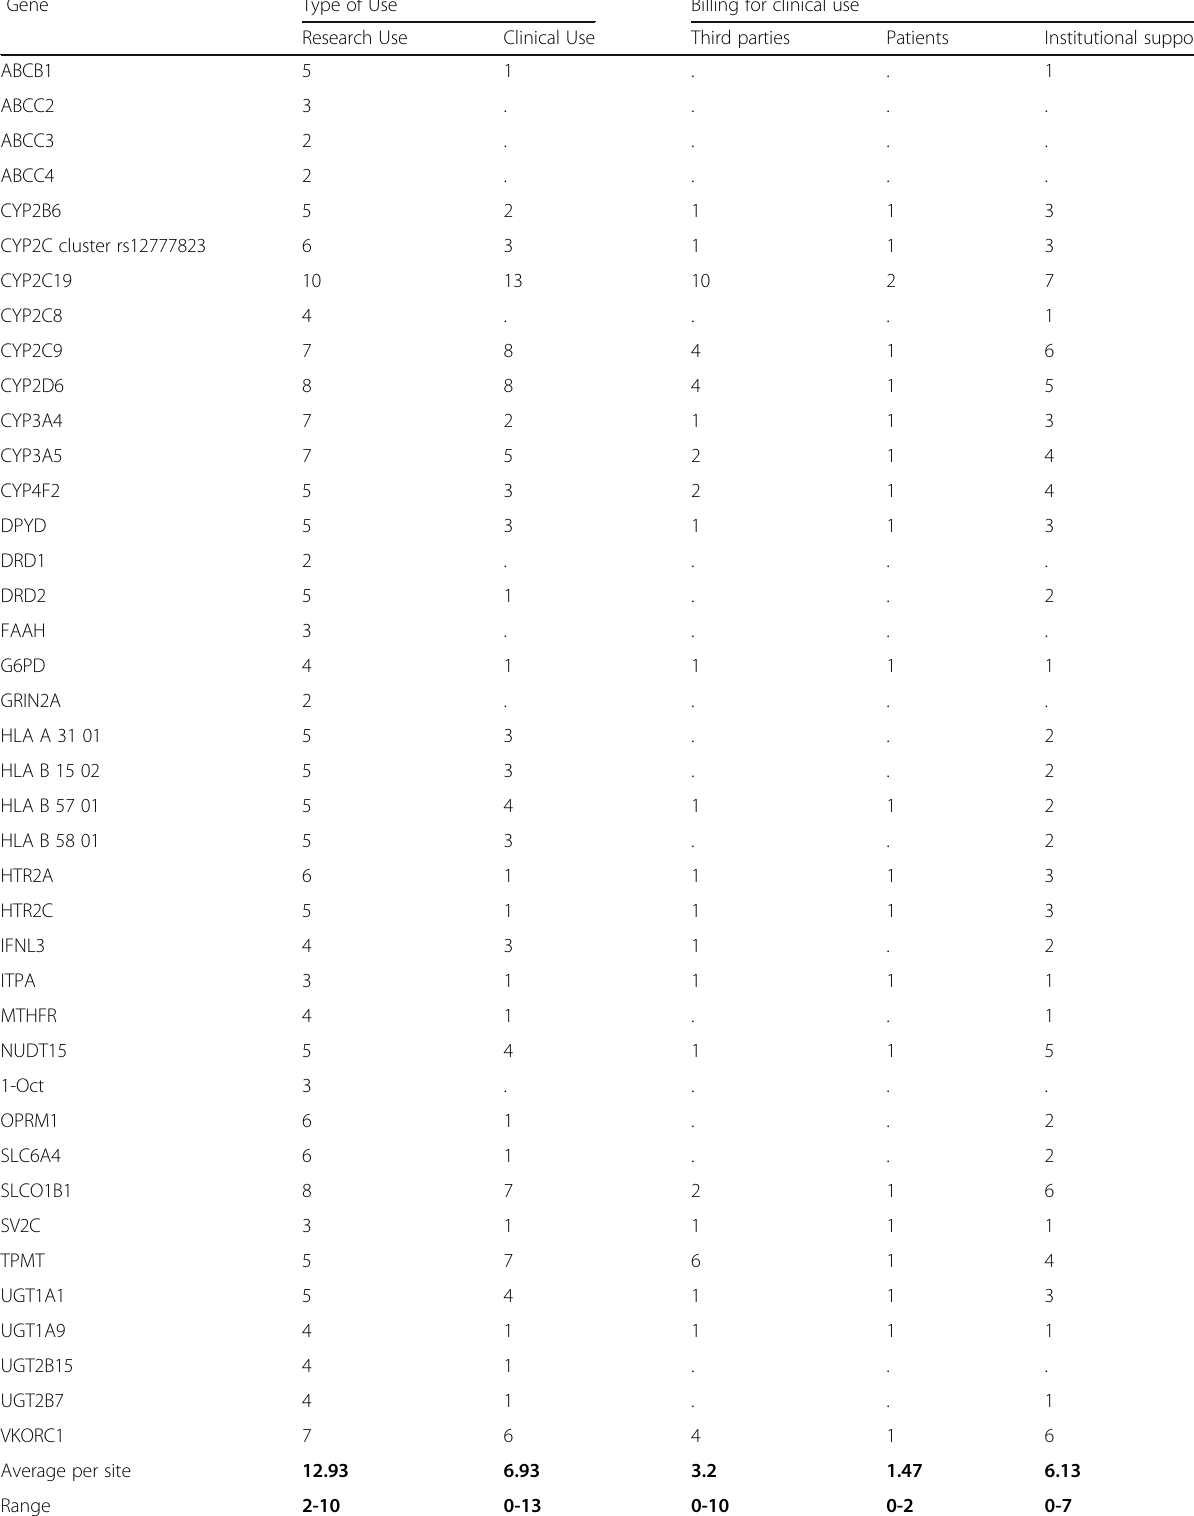
Table 5 PGx tests used in research and clinically and funding source for clinical use Gene Type of